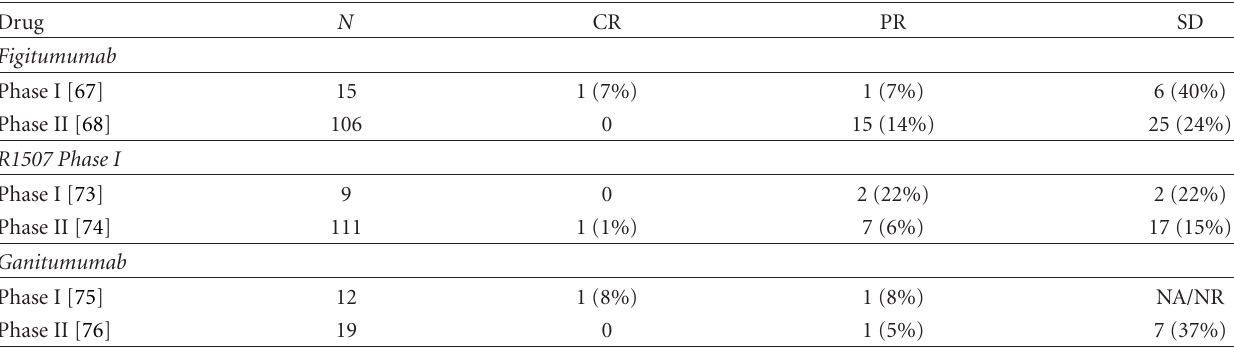
Table 2: Responses in clinical